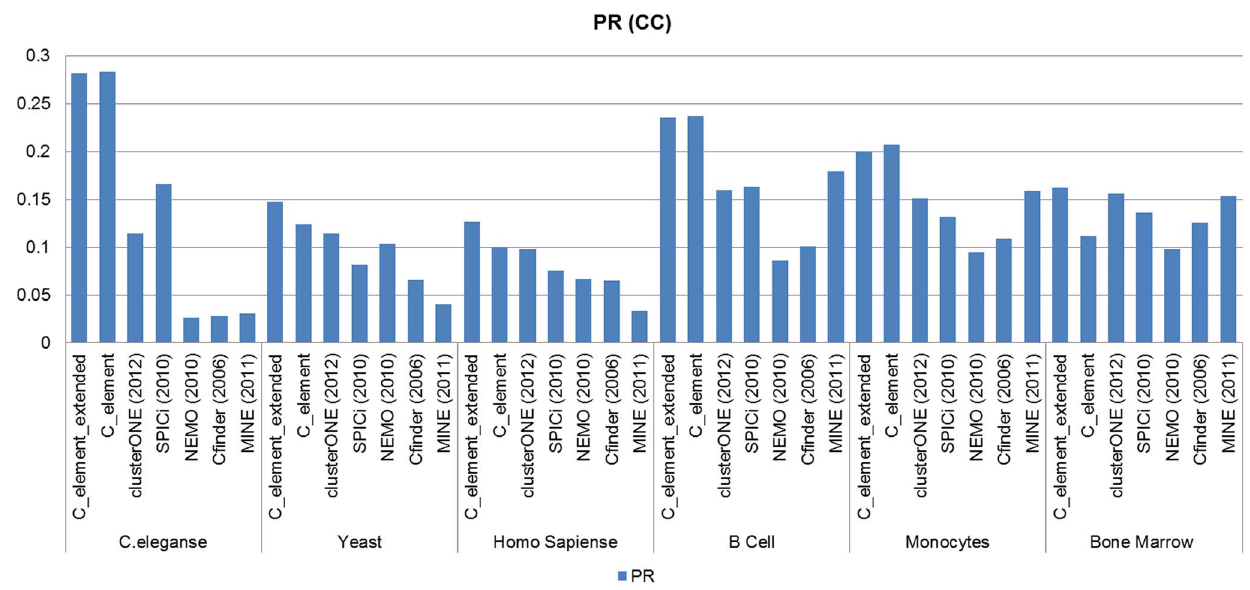
Figure 9. The results of Precision–Recall measure analyses on the results of different algorithms on different network datasets when GOCC derived functional modules were considered.